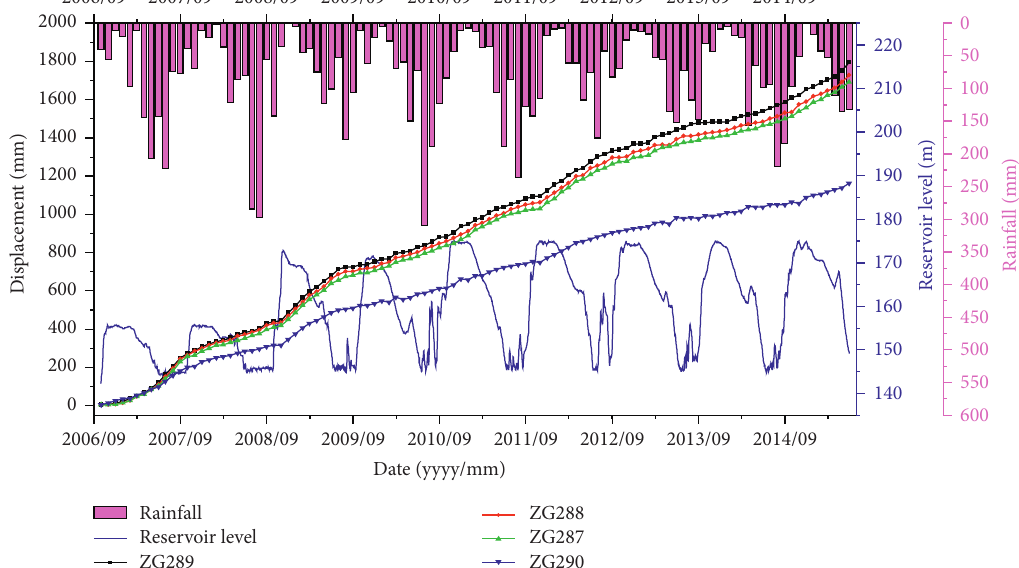
Figure 6: Monitoring data for rainfall, reservoir level, and Tanjiahe landslide displacement from October 2006 to June 2015.